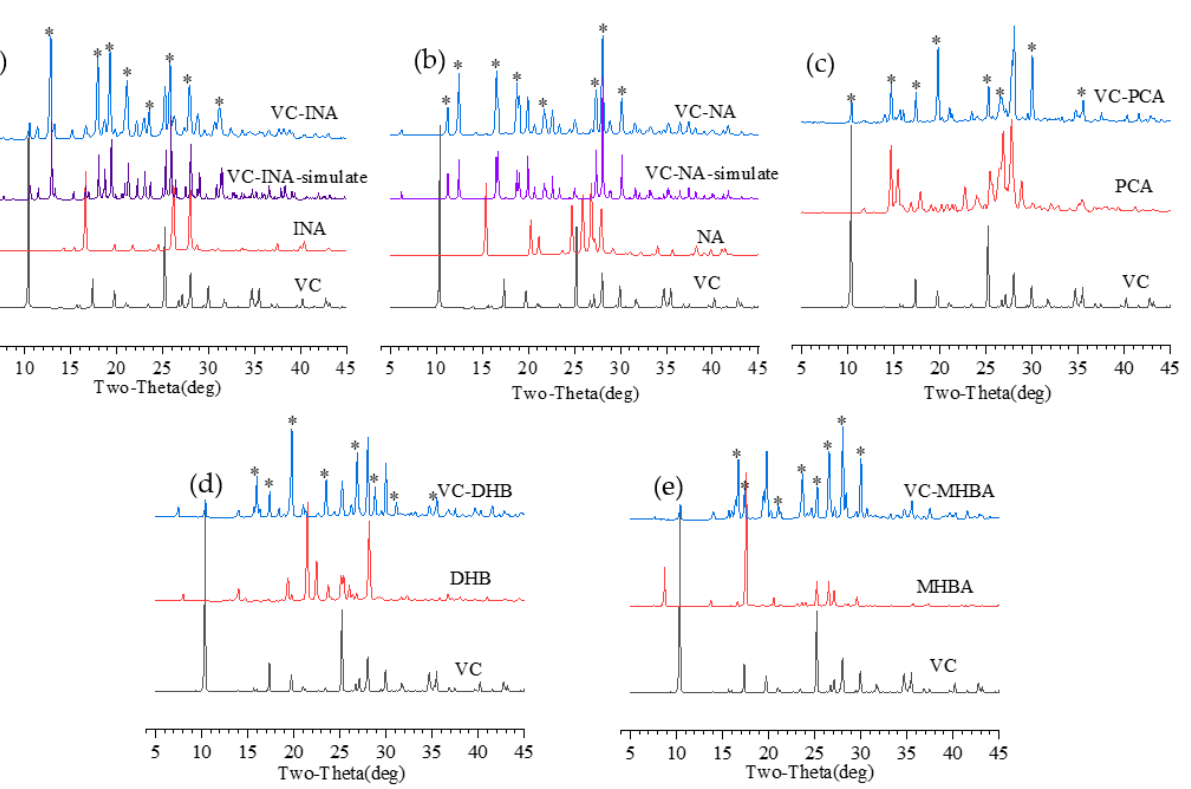
Figure 4. Schematic diagram of PXRD patterns of ( a ): VC-INA; ( b ): VC-PCA; ( c ): VC-NA; ( d ): VC-DHB; ( e ): VC-MHBA. * represents the characteristic diffraction peaks of co-crystals.